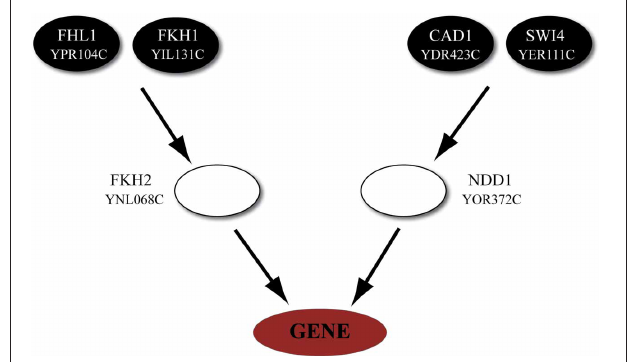
FIGURE 1 | Representative example of a regulatory cascade. The regulatory cascade that is formed based on module 20 in Category A (heat shock). The module, as derived from GRAM, consists of seven genes (YLL006W, YDR043C, YML127W, YFL067W, YLL005C, YLL003W, and YJL225C) which are regulated by the transcription factors FKH2 and NDD1. While the biological cascade is common for all genes, a different ANN is trained/validated/tested based on the expression of every target gene in the module. Most of these genes are implicated in the stress response as evidenced from their MIPS annotation (Mewes et al.,